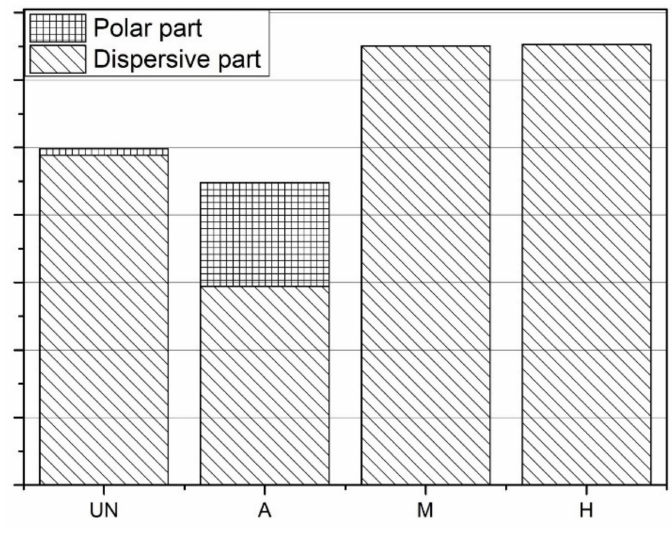
Figure 5. Comparison of the surface free energy of GTRs studied.